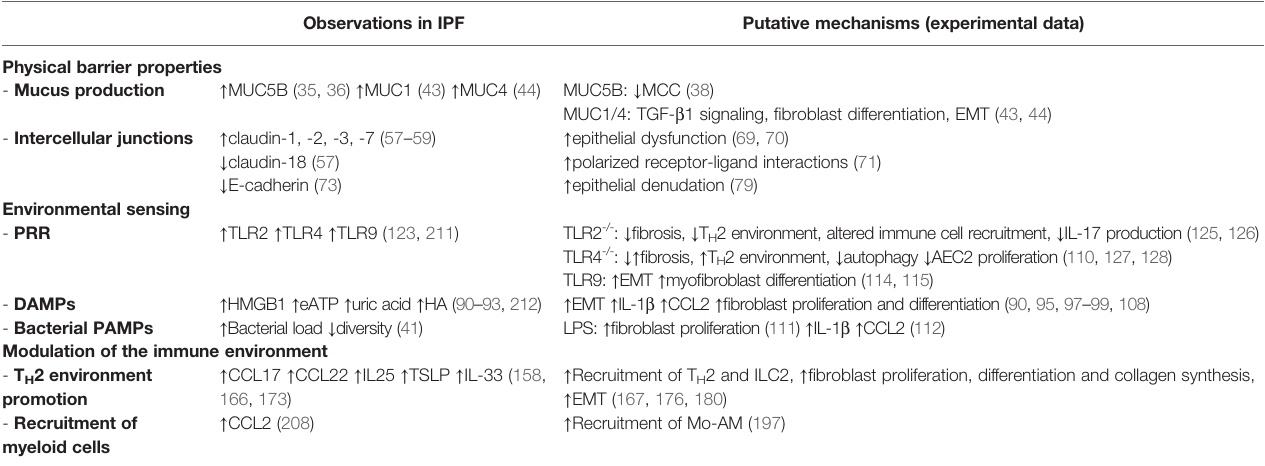
TABLE 1 | Summary of the epithelial-immune interactions in IPF. Observations in IPF Putative mechanisms (experimental